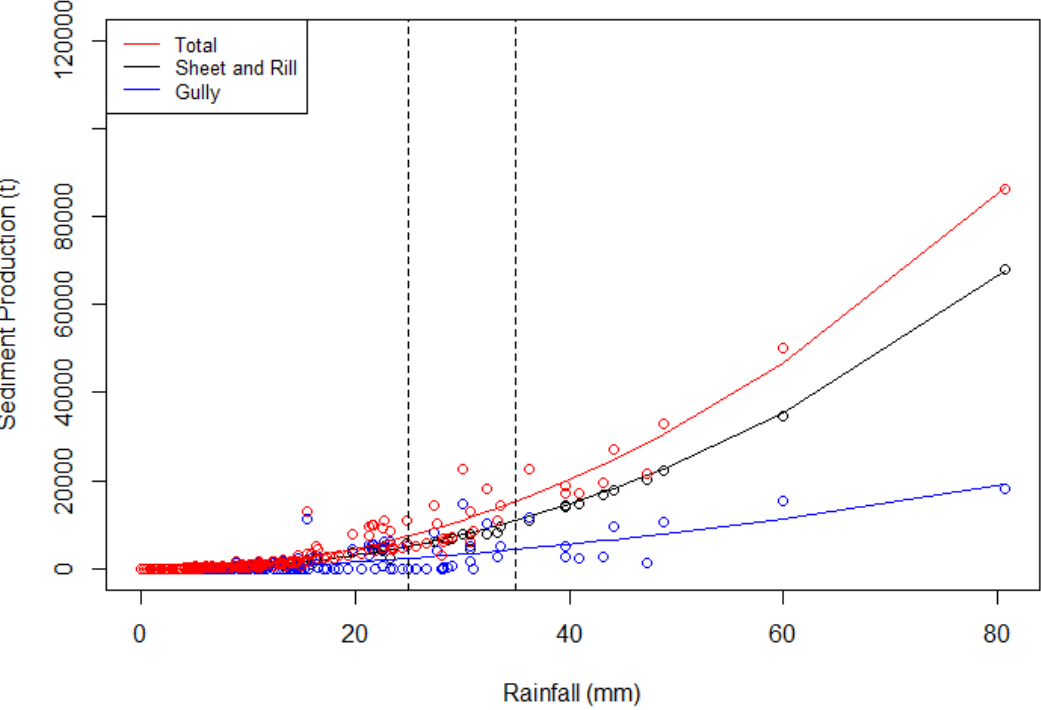
Figure 11. Simulated sediment load by erosion processes in LLCW. The vertical dashed lines indicate the range of the rainfall threshold for gully erosion observed in the field during 2013 to 2018.